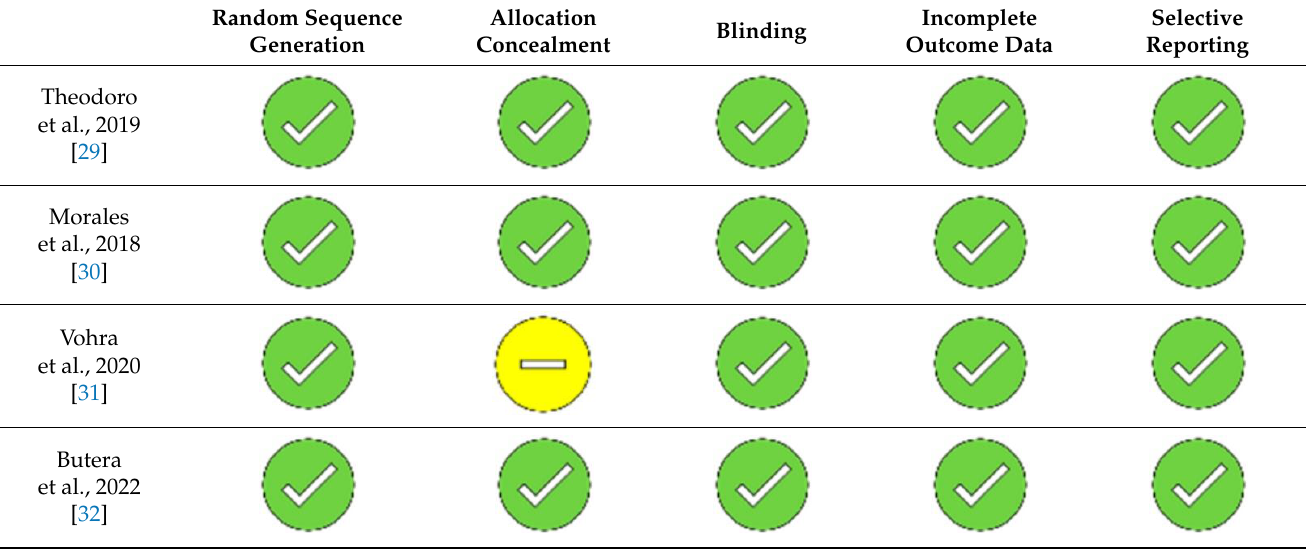
Table 2. Risk of bias (ROB) of the studies included in this review: the green symbol represents a low risk of bias, while the yellow symbol represents a high risk of bias.